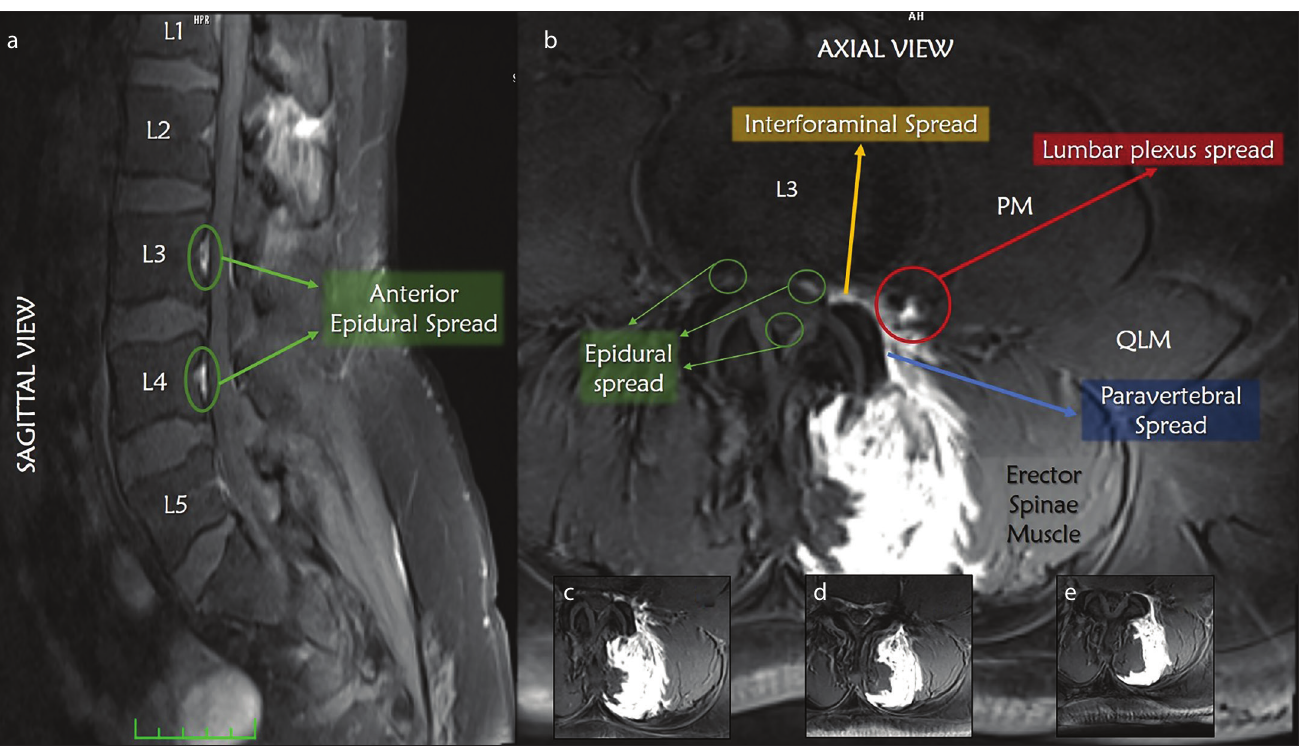
Figure 2. a-e. Magnetic resonance imaging scan (T1-weighted with fat saturation) with gadolinium contrast injected at the level of L4. a) Sagittal view and epidural spread. Axial views b) L3, c) L2, d) L4, and e) L5 b). PM: psoas major; QLM: quadratus lumborum muscle Yellow arrow: interforaminal spread; red arrow: lumbar plexus spread; blue arrow: paravertebral spread; green arrows: epidural